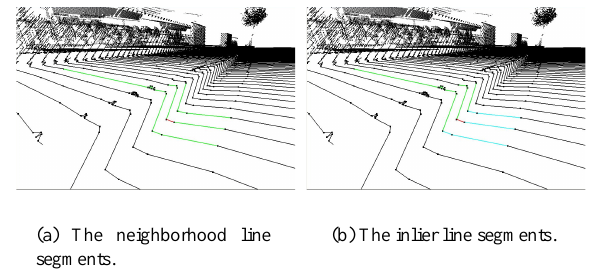
Figure 7: Definition of neighboring line segment.